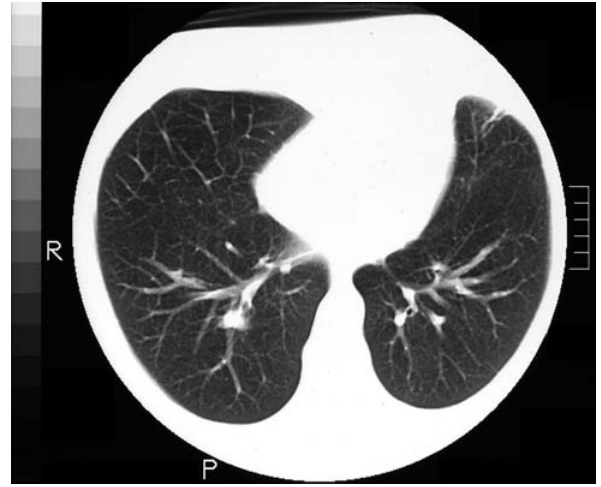
Figure 2 - Tomographic slice: signs of diffuse, possibly chronic, bronchial disease with diffuse thickening of the bronchial walls.